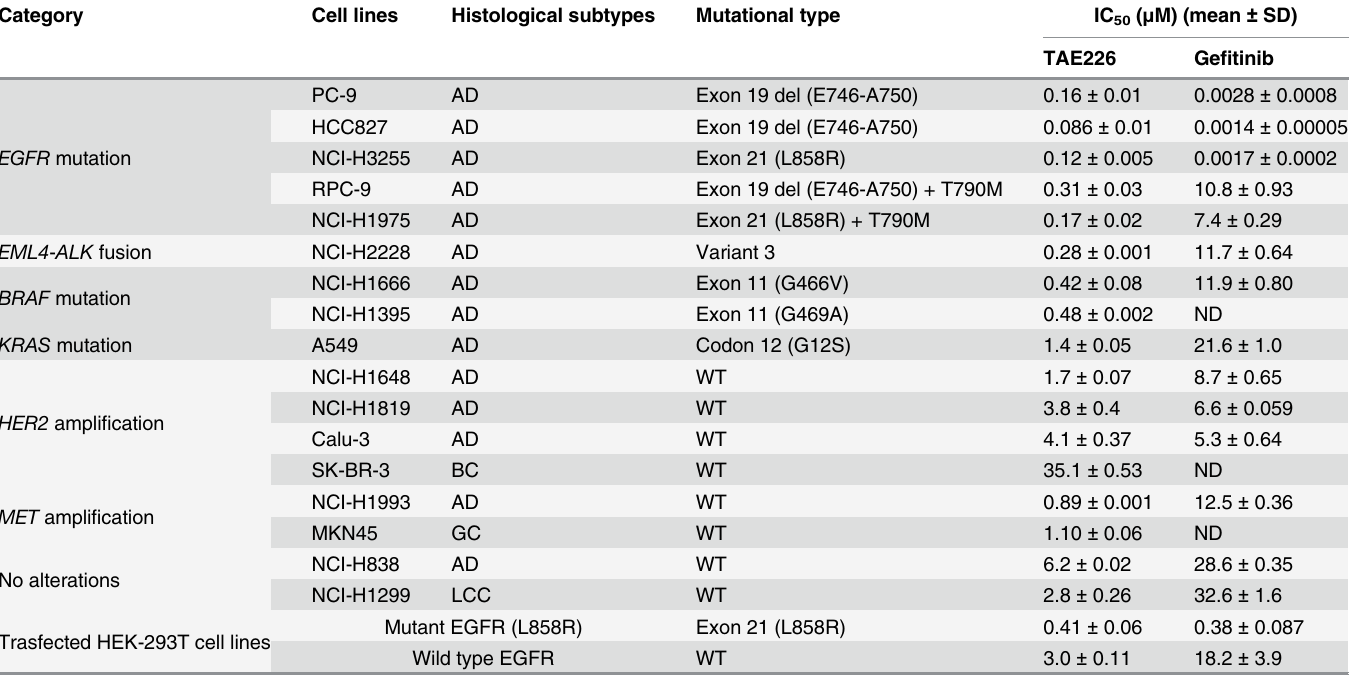
Table 1. Characteristics and drug sensitivities of gefitinib and TAE226 in cell lines. Category Cell